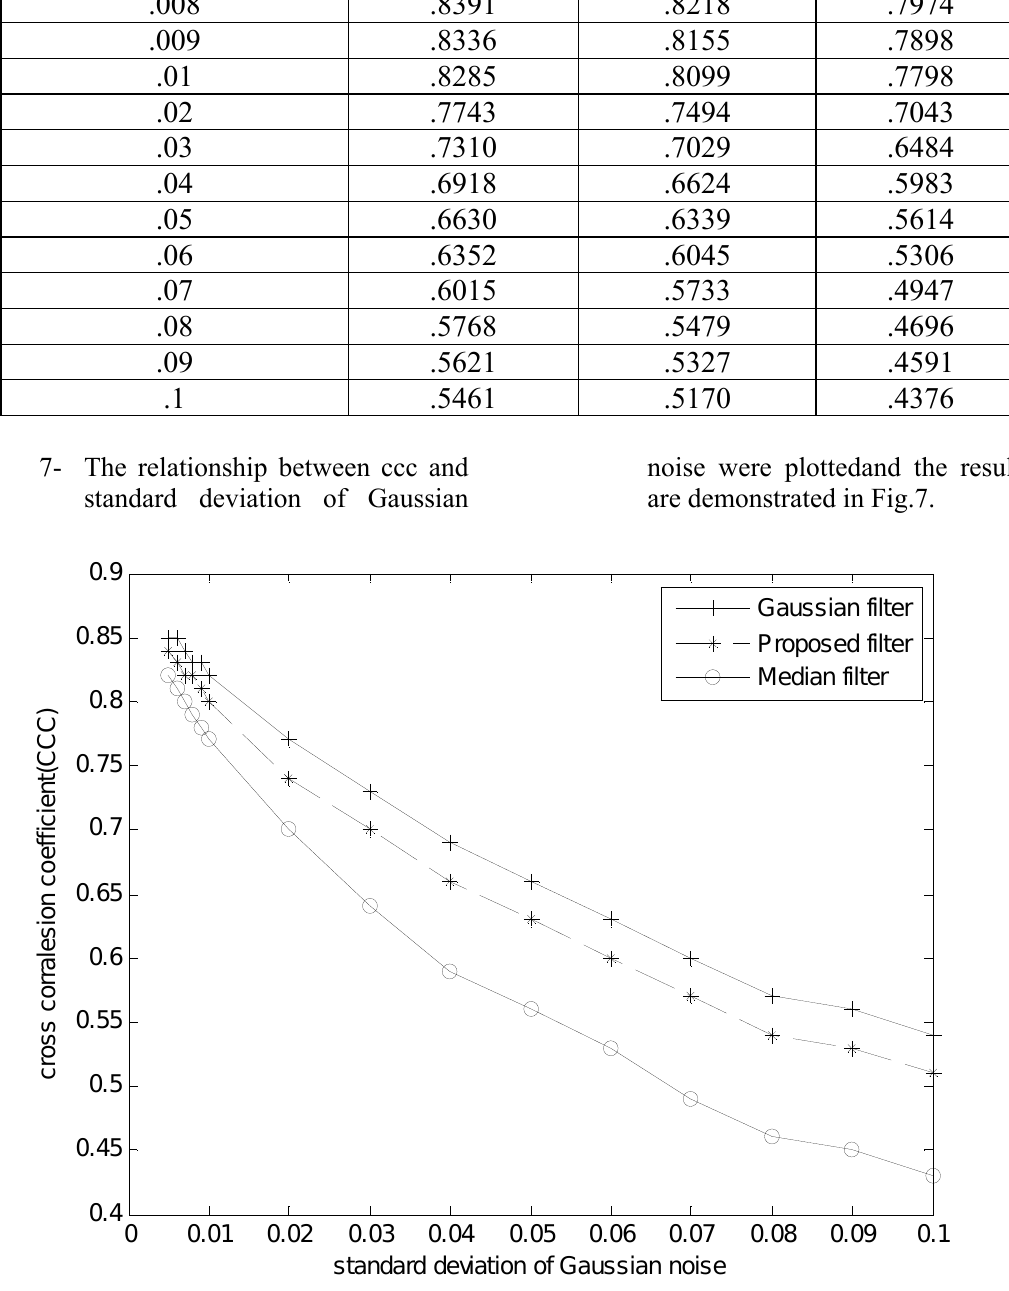
Fig. 7: The relationship between ccc and the standard deviation of the Gaussian noise in gray satellite